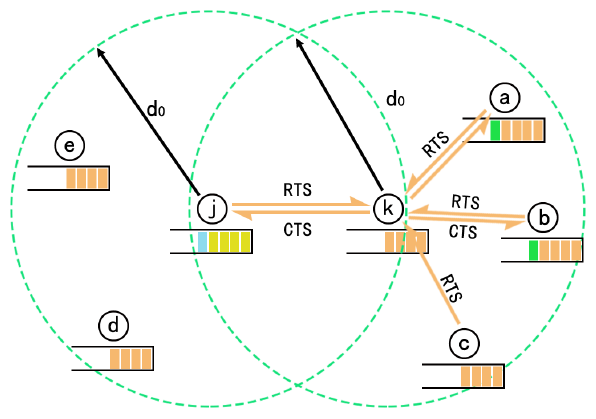
Figure 7. Interfering